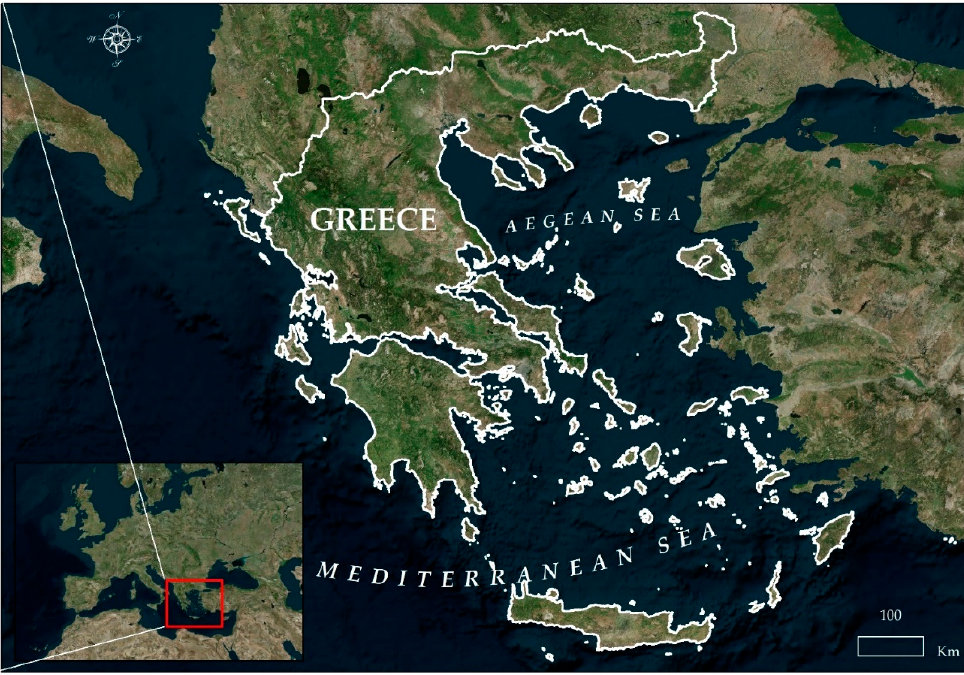
Figure 2. Greece, the main study area.